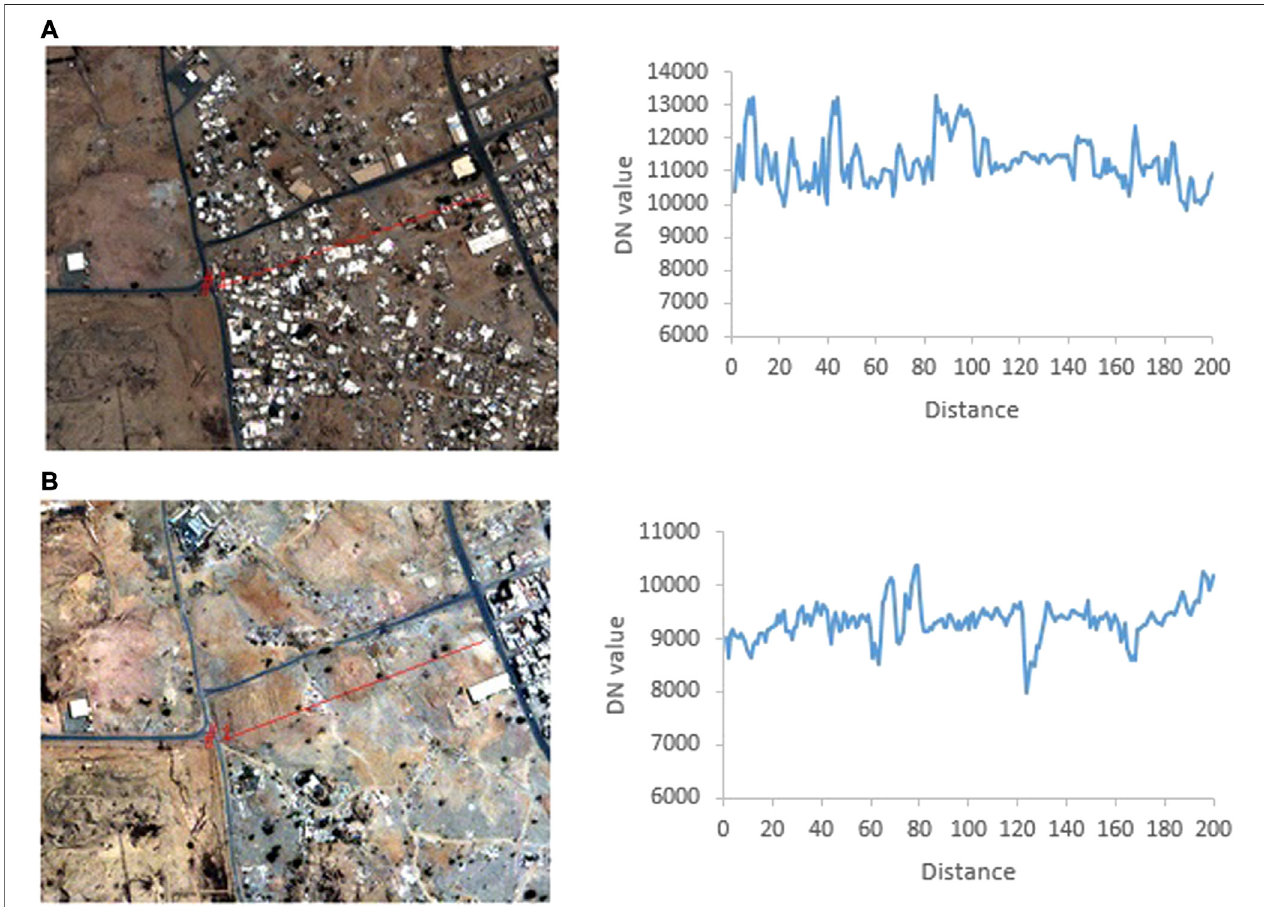
FIGURE 10 | The spectral pro fi les for an affected (A) , and damaged (B) areas. The pro fi le is derived from QuickBird-2 data.